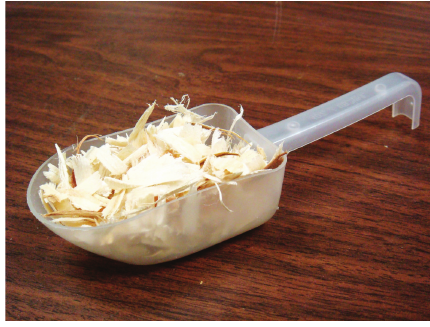
Figure 7: The scoop used for loading wood chips.